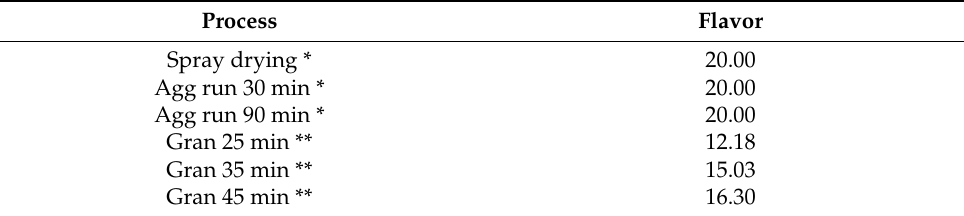
Table 2. Theoretical orange oil weight in 100 g powder for all samples assuming 100% retention.